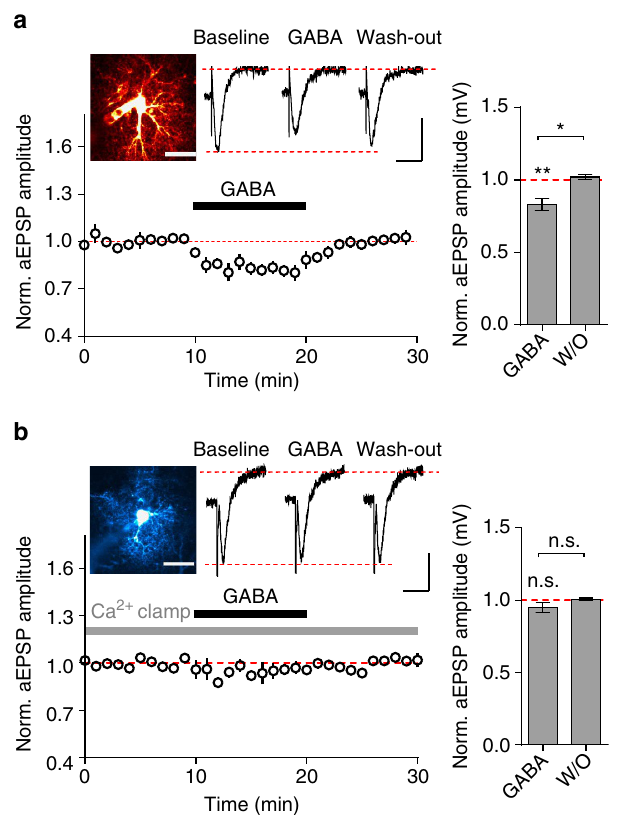
Figure 6 | Astrocytic Ca 2 þ clamp prevents suppression of field EPSPs by GABA. ( a ) Time course (left) and a summary plot (right) of the effects of GABA on normalized field EPSPs recorded through CA1 passive astrocytes (aEPSPs; n ¼ 6 cells from 5 animals). Inset: An example of a patched astrocyte loaded with Alexa 594 and sample traces of aEPSPs (conditions indicated above traces). Image scale bar, 20 m m, aEPSP scale bars: vertical 0.2mV, horizontal 30ms. ( b ) Single cell examples and summary plots ( n ¼ 5 cells from 4 animals) of GABA effect on aEPSPs recorded though an astrocyte filled with an internal solution buffered to a nominal Ca 2 þ concentration of 50–80nM (Ca 2 þ clamp). Layout as in a ; vertical aEPSP scale bar, 0.3mV, horizontal 30ms; image scale bar, 20 m m; error bars represent s.e.m.’s; * P o 0.05, ** P o 0.01, n.s.—non-significant (paired t